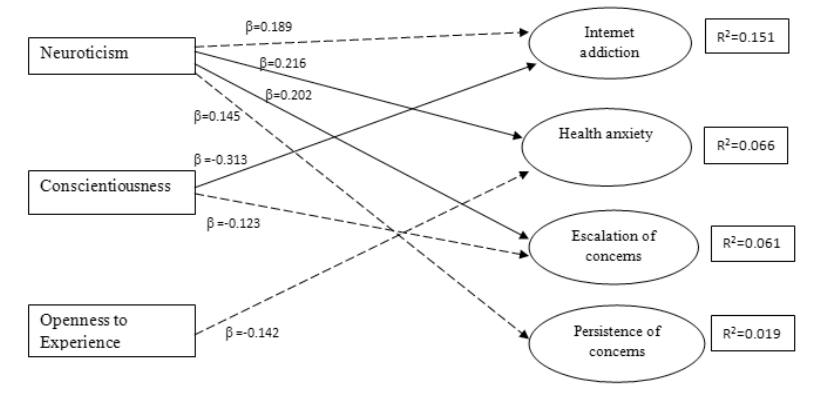
Fig.1. Signi (cid:222) cant effects of personality traits on Internet addiction, anxiety aroused by online health information seeking, escalation, and persistence of health concerns Source: Own